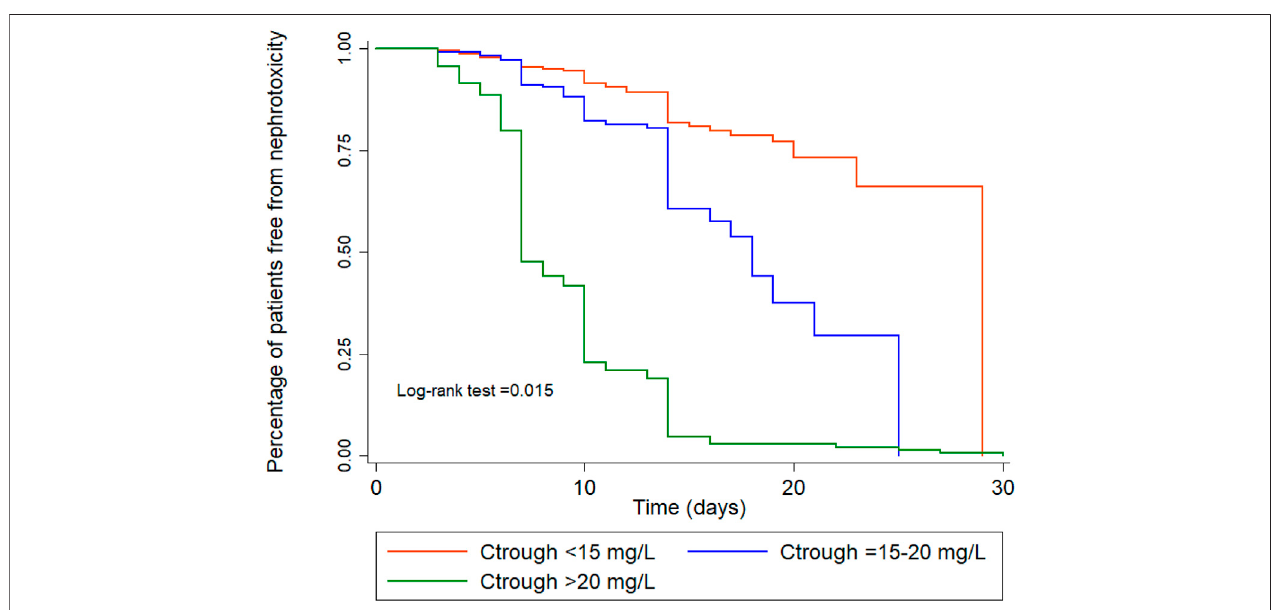
FIGURE 3 | Kaplan-Meier survival analysis for nephrotoxicity for the three trough concentration groups, adjusted for age, gender, APACHE II score, albumin, species, colistin, chronic kidney disease, baseline Scr.